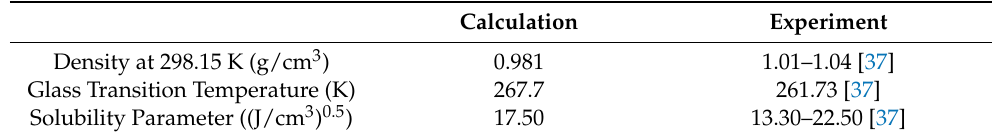
Table 3. Asphalt binder model validation data.